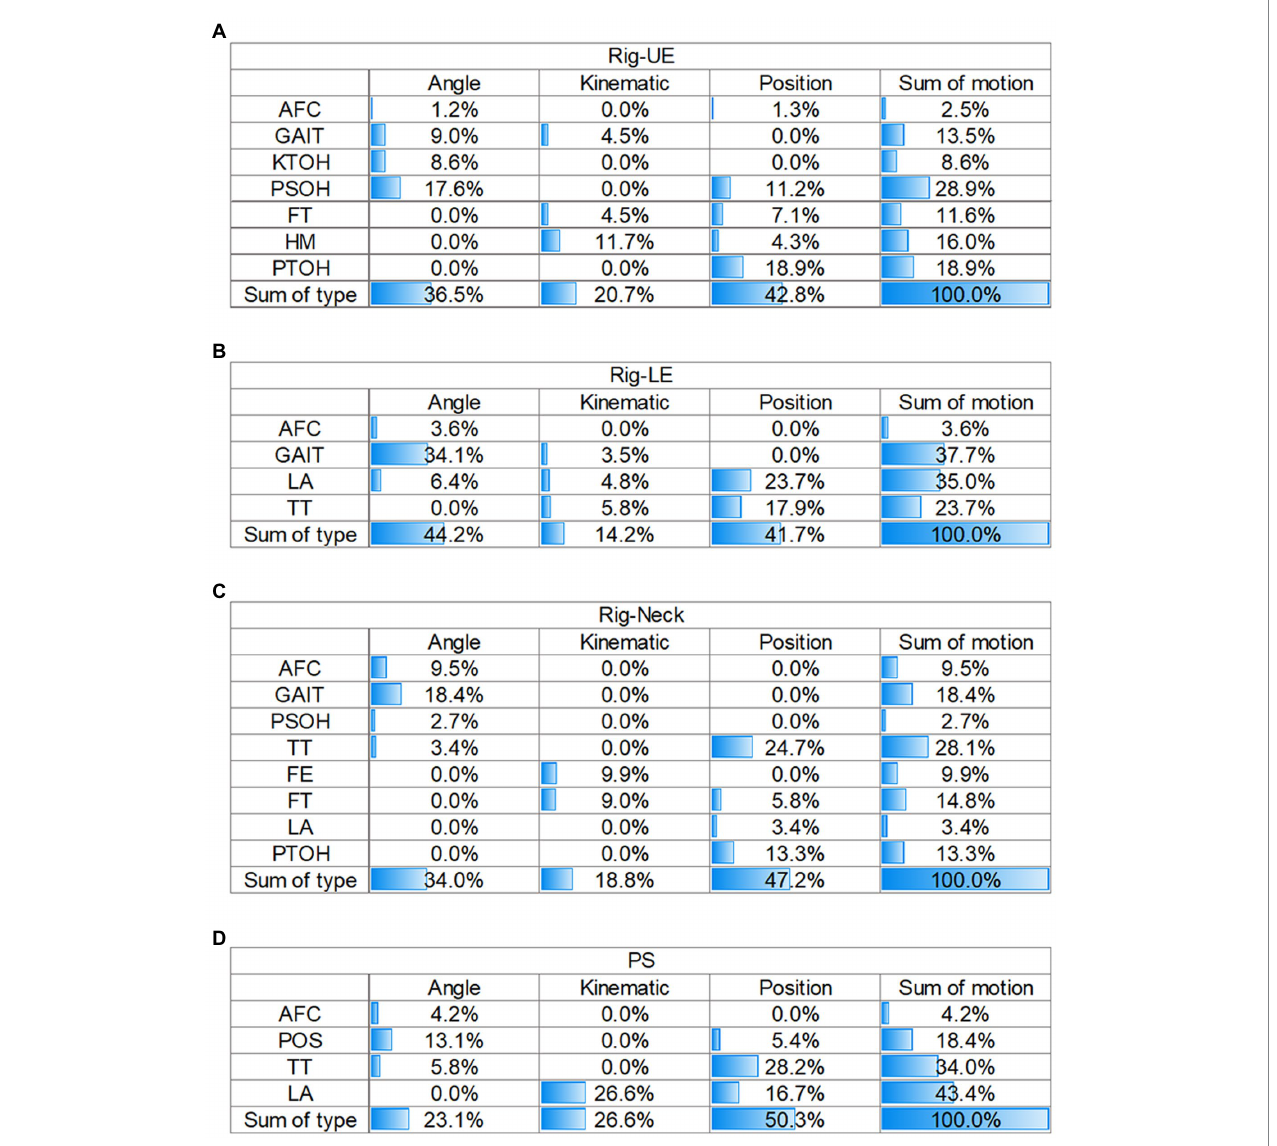
FIGURE 3 Matrix of contributions of different sources in the four models. (A) Rig-UE. (B) Rig-LE; (C) Rig-Neck. (D) PS. Rig, rigidity; UE, upper extremity; LE, lower extremity; PS, postural stability; AFC: arising from chair; FE, facial expression; FT, finger tapping; HM, hand movements; KTOH, kinetic tremor of the hands; LA, leg agility; POS, posture; PSOH, pronation/supination of the hands; PTOH, postural tremor of the hands; TT, toe tapping; AFC: arising from chair; and FE, facial